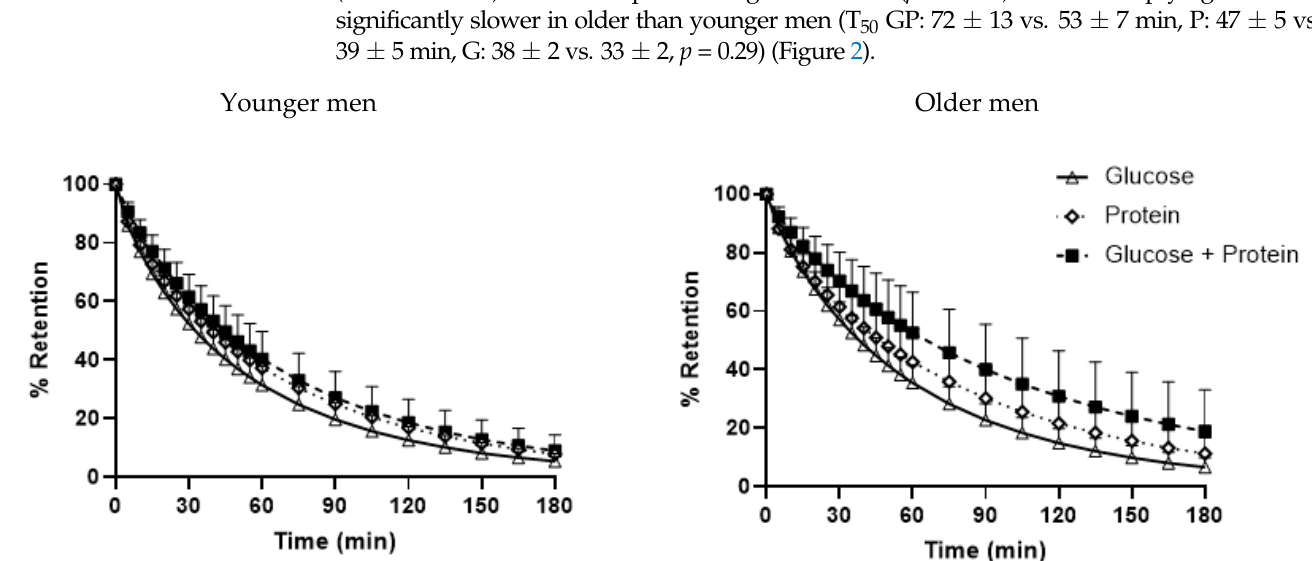
Figure 2. Intragastric retention (%) following drink ingestion containing (i) 30 g whey protein (P), (ii) 30 g glucose (G) or (iii) 30 g whey protein plus 30 g glucose (GP) in younger ( n = 5) and older ( n = 10) men. Effects of age and drink condition and the interaction effect were determined using a mixed-effect model with baseline concentrations as covariates and post hoc Bonferroni correction. T = 0 min refers to the point immediately before the drink consumption. Drink-condition effect : p < 0.001 gastric emptying of GP was slower than P and both emptied slower than G.